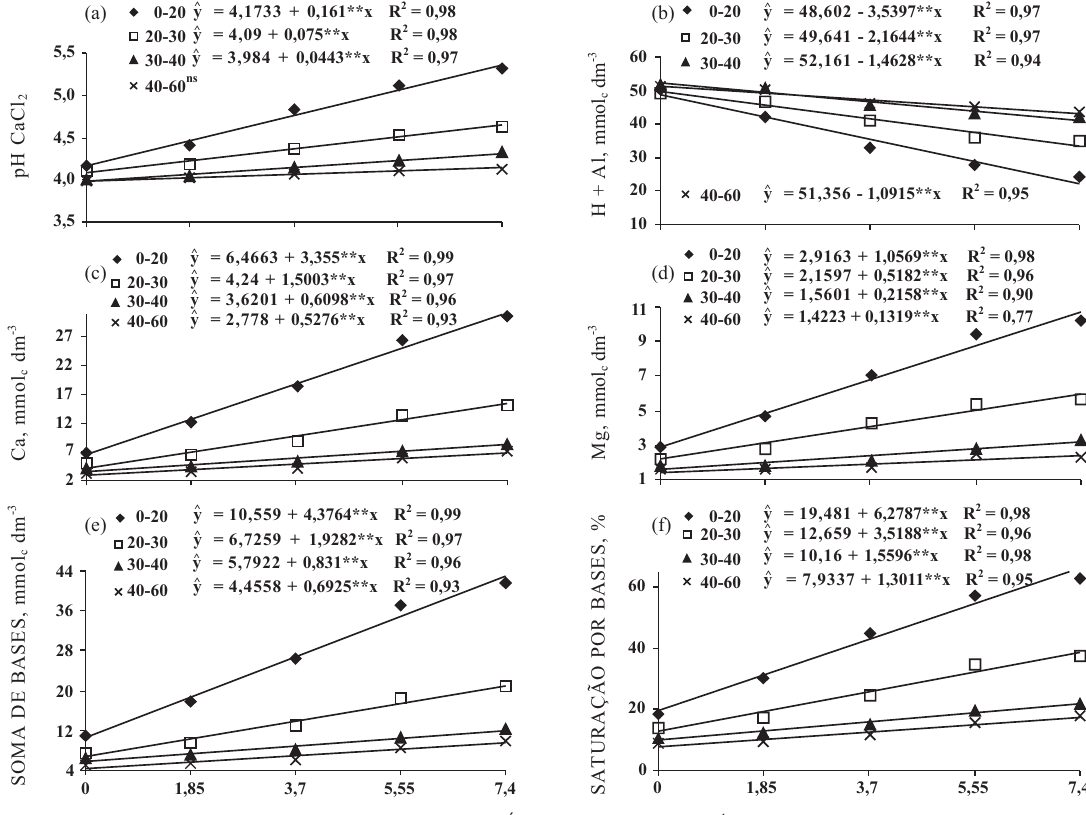
Figura 1. Efeito da aplicação de calcário no pH (a), H + Al (b), Ca (c), Mg (d), soma de bases (e) e saturação por bases (f), em diferentes profundidades do solo, em amostras da entrelinha da goiabeira. Os pontos são médias de 12, 10, 10 e nove épocas de amostragem, respectivamente, para as camadas de 0–20, 20–30, 30–40 e 40–60 cm e quatro repetições. ** Significativo p < 0,01 e * Significativo p <